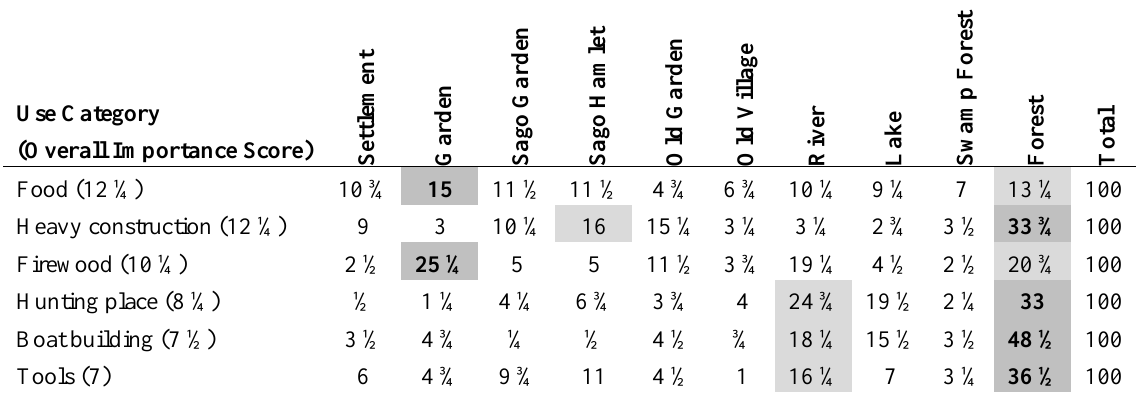
Table 1. The importance of land types for each respective use category. Use categories are ordered from highest to lowest importance score and described below. Grey highlighted and bold are the highest scoring land types for each category, lighter grey shows the second highest score. All data presented are combined scores of four PDM